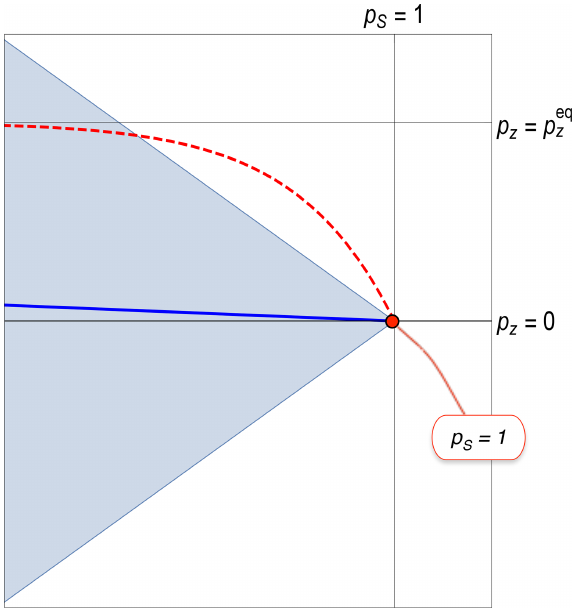
Figure 8. Non-equilibrium spin dynamics for an ensemble of spin- 1/2 pairs, with T S (cid:29) T 1 , where T S is the rate constant for the decay of singlet order, and T 1 is the rate constant for the equilibration of z polarization. The plot shows an expanded view of Fig. 4 in the vicin- ity of the red dot, which represents an initial state of 100% singlet polarization. Dashed red line: trajectory predicted by the inhomo- geneous master equation. Solid blue line: trajectory predicted by the Lindbladian master equation. Both trajectories eventually lead to the same thermal equilibrium state, represented by a point with coordinates { 0 ,p z eq } , which is well beyond the left-hand edge of the plotted region and is not